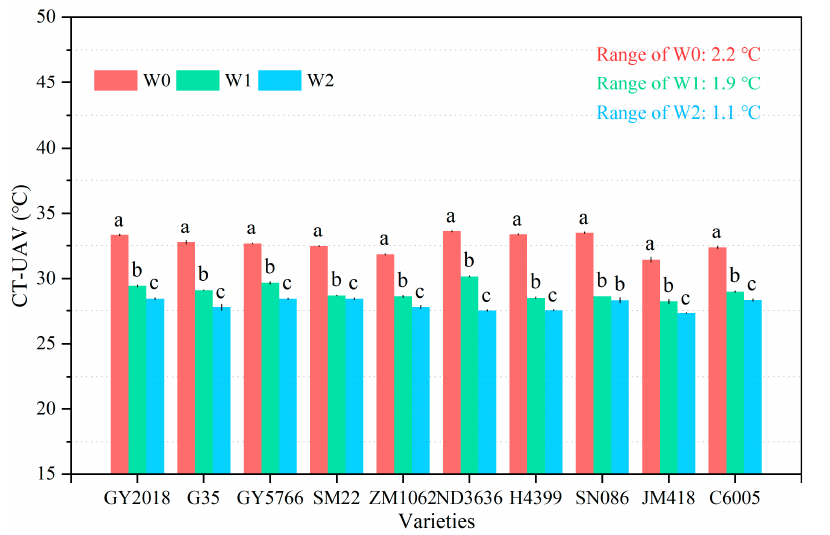
Figure 7. Canopy temperature of wheat varieties based on UAV thermal imagery on 20 May under W0, W1 and W2 treatment. The range means maximum canopy temperature minus minimum canopy temperature among varieties under the same irrigation treatment. Duncan’s multiple range test was used to compare the mean values of canopy temperature in different water treatments. The means followed by different letters are significantly different at p < 0.05.